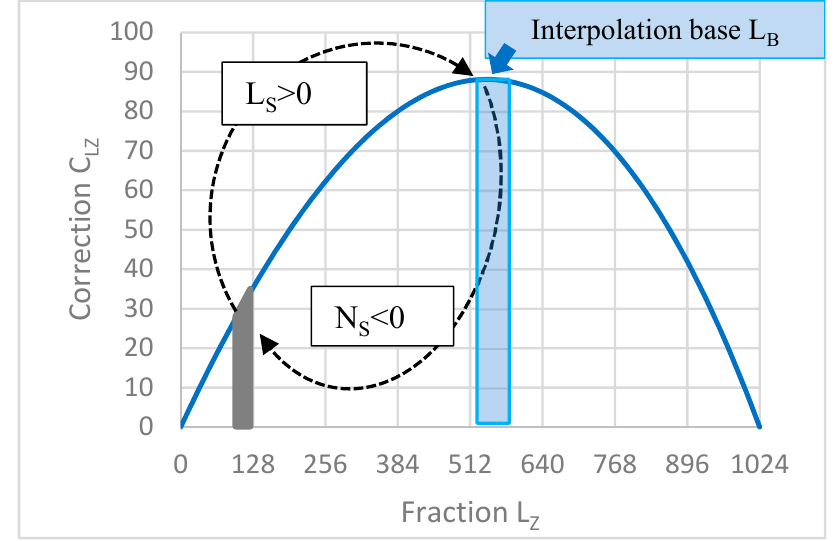
Figure 2. Looping in sectors: conversion from L Z to N Z for M =